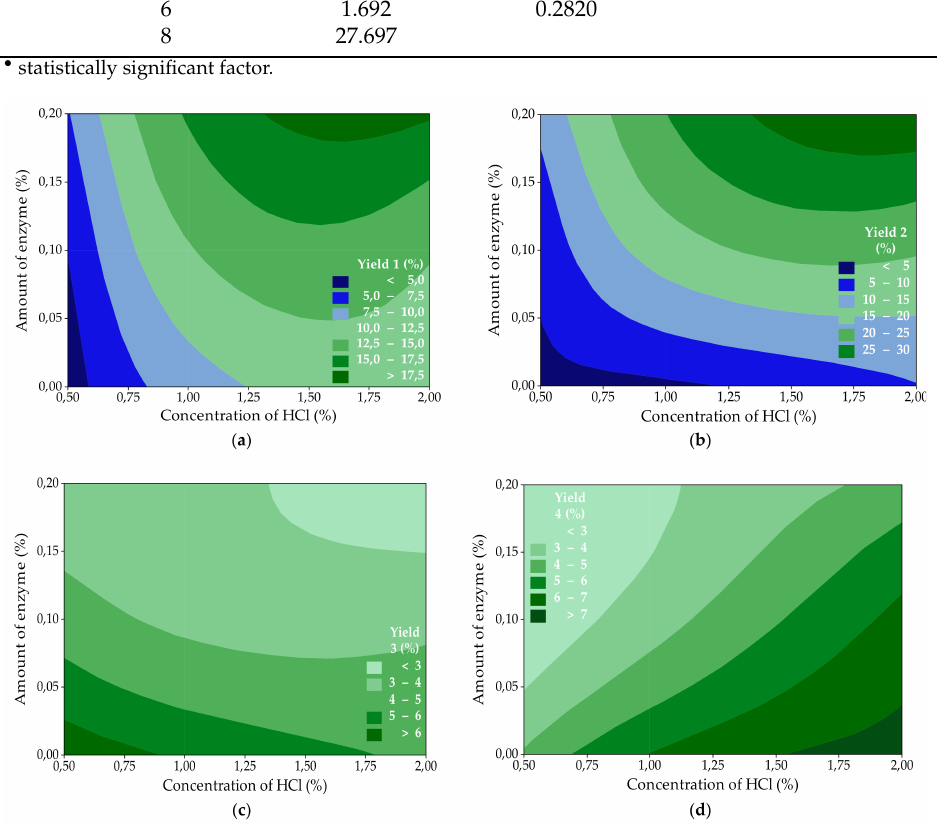
Figure 1. The influence of concentration of HCl and the amount of enzyme on gelatin yields: ( a ) the yield of the first gelatin fraction; ( b ) the yield of the second gelatin fraction; ( c ) the yield of the third gelatin fraction; ( d ) the yield of the fourth gelatin